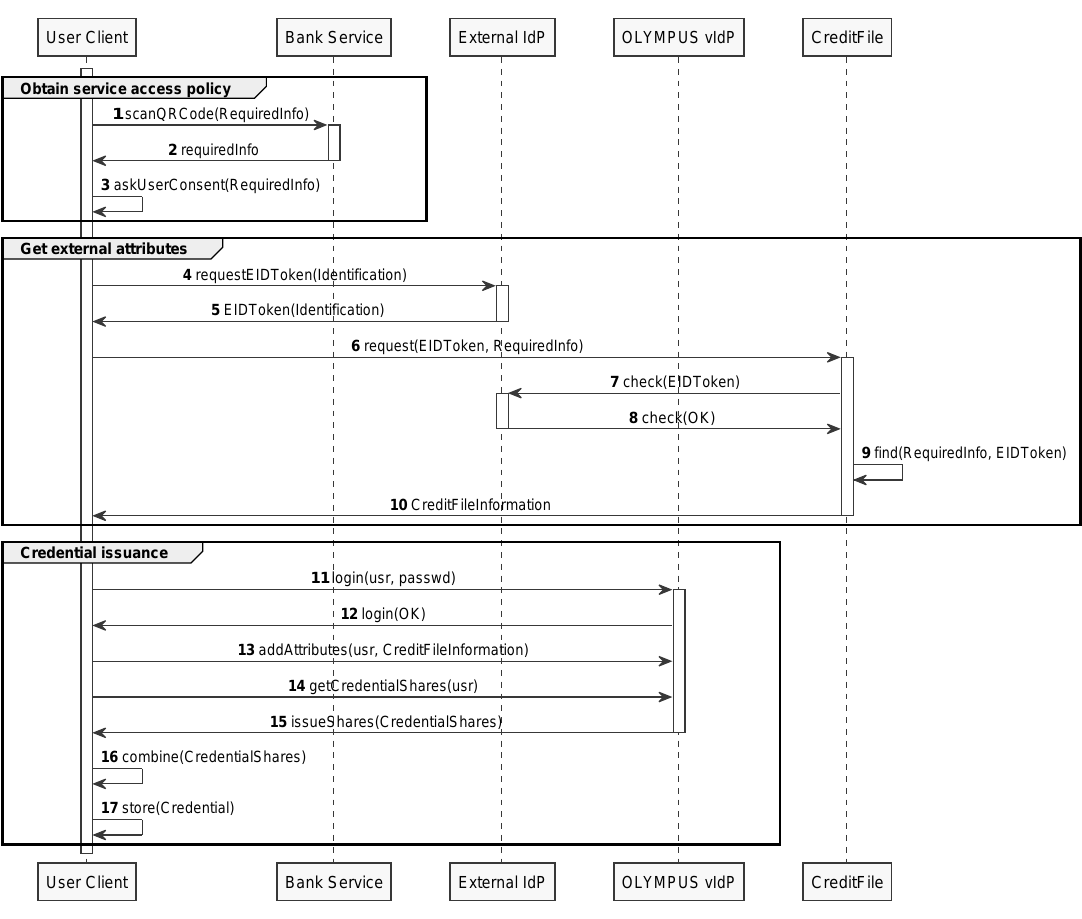
Figure 4. Credit File issuance process with